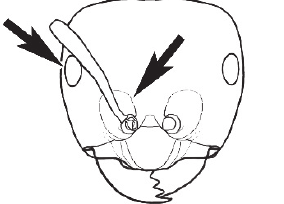
side of head capsule) ................................................................................. 36